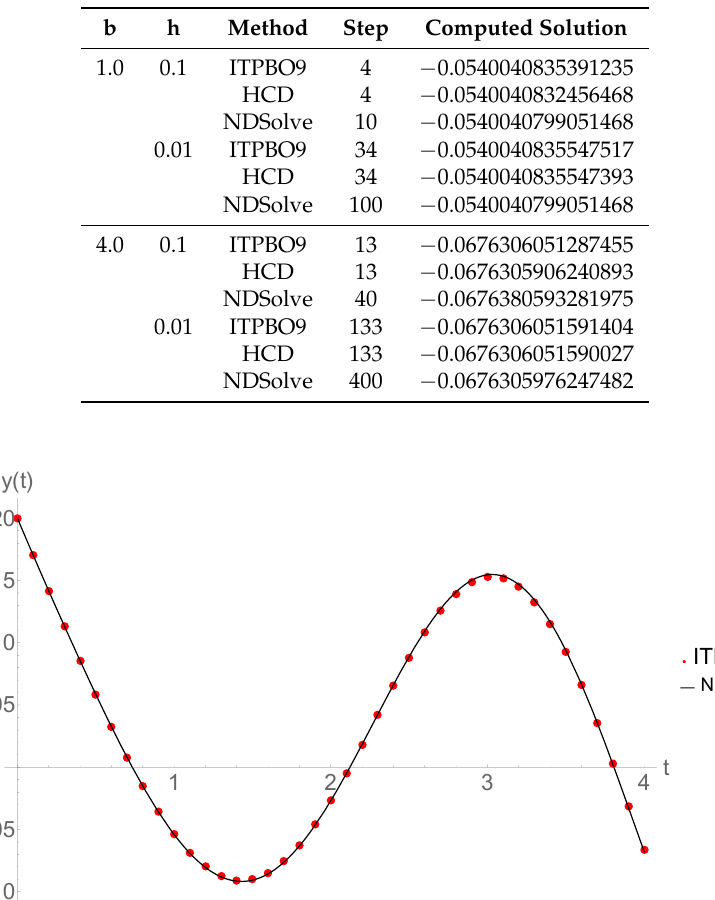
Figure 5. Response curve concerning Equation (29) with h = 0.1 in t ∈ [ 0,4 ]